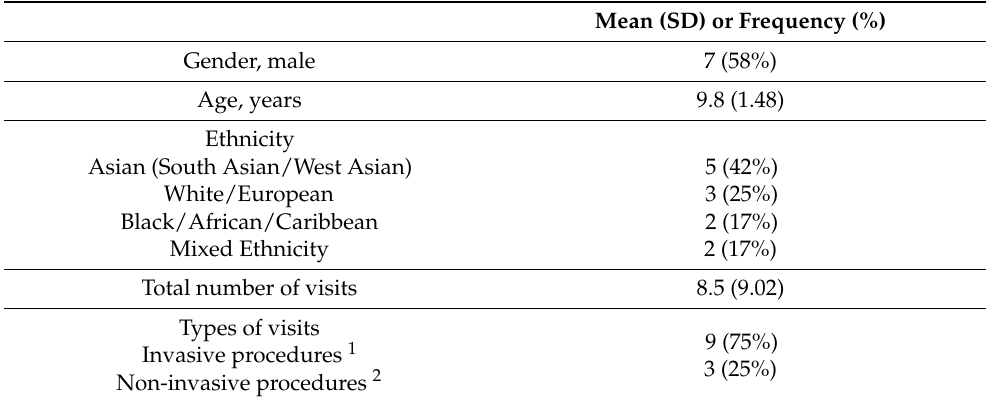
Table 3. Summary of participants’ characteristics ( n =